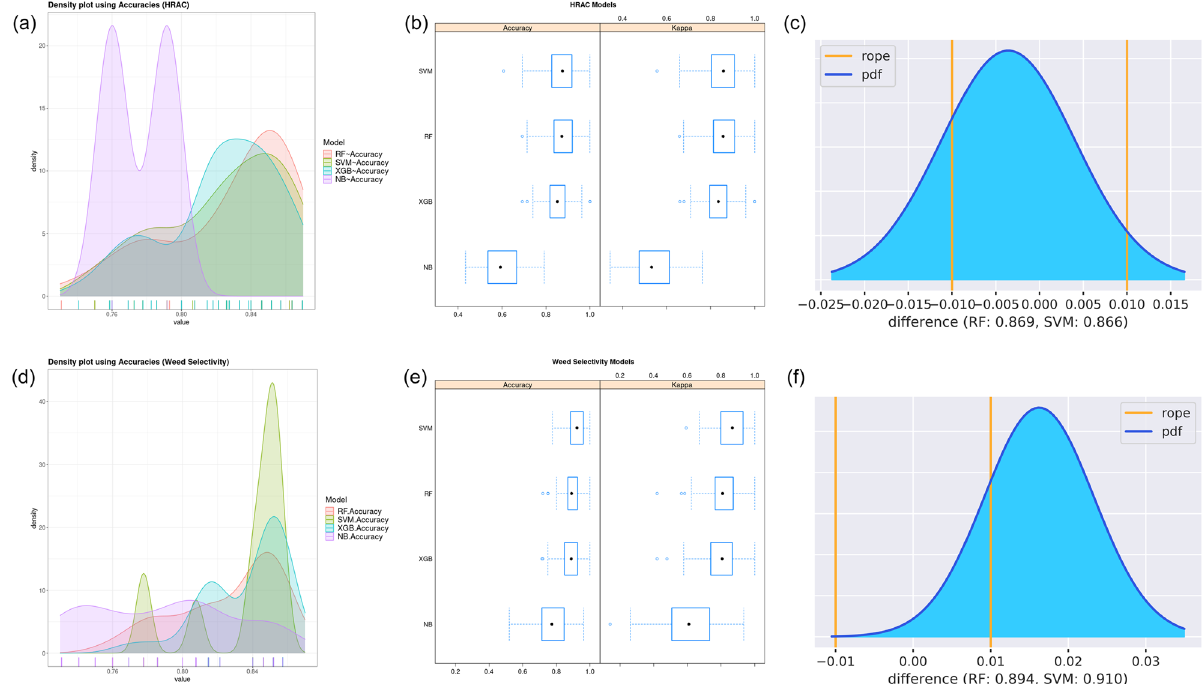
Figure 1. Comparing performance of the four ML classifiers for MoA predictions. ( a , d ) Density accuracy plot. ( b , e ) Box plots of distributions of resampled accuracies and kappa values. ( c , f ) Probability density plot for accuracy differences between the RF and SVM classifiers. The plots ( a )–( c ) described MoA classifiers (Table 2) and those ( d )–( f ) present comparison of weed selectivity models built with nine descriptors including log P (Table 3). The RF and SVM MoA classifiers are largely equivalent since 75.7% of posterior probability distribution is inside the region of practical equivalence (rope, the differences of accuracy are less than